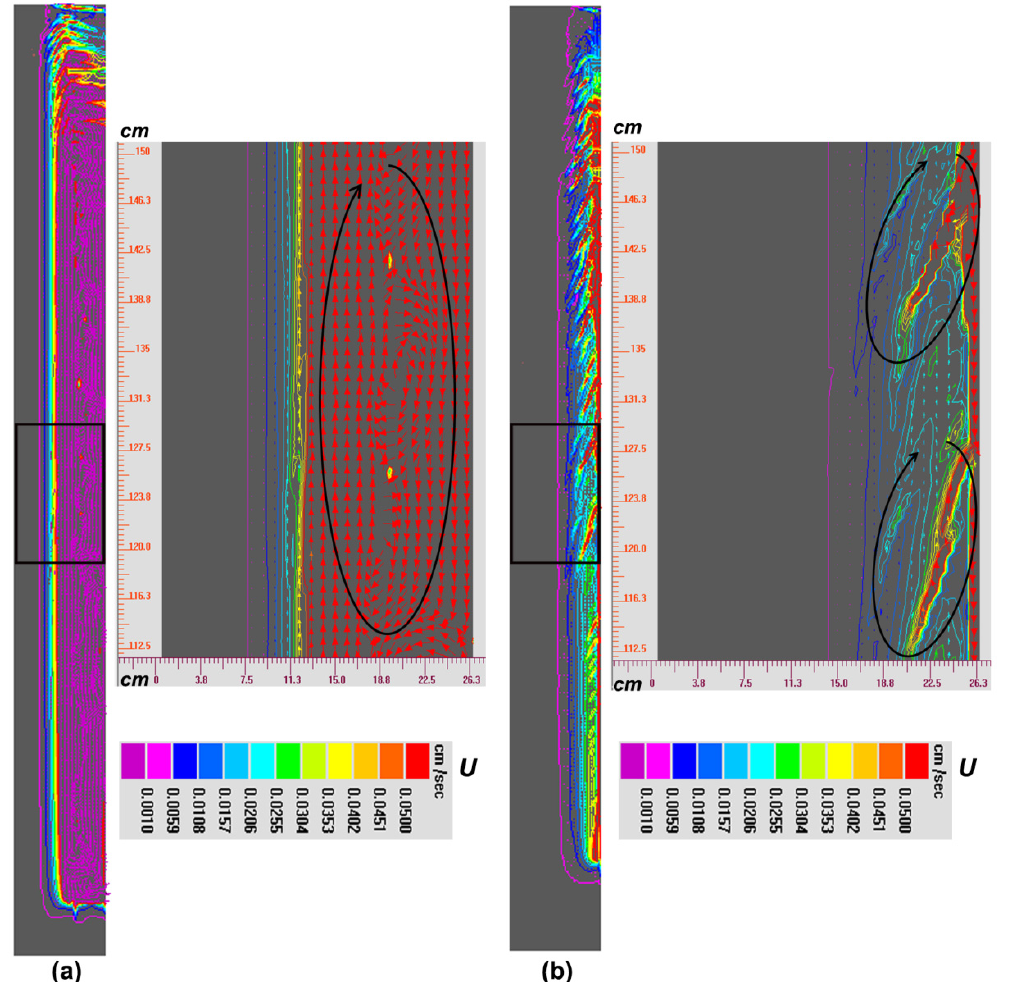
Figure 9. The distribution and evolution of the flow field during the early ( a ) and middle ( b ) stages of solidification in the NbTi ingot. ( a ) 1000 s; ( b ) 2700 s. The enlarged views of the flow field in the black box are also attached, respectively. The flow circulation is indicated by the black arrow.